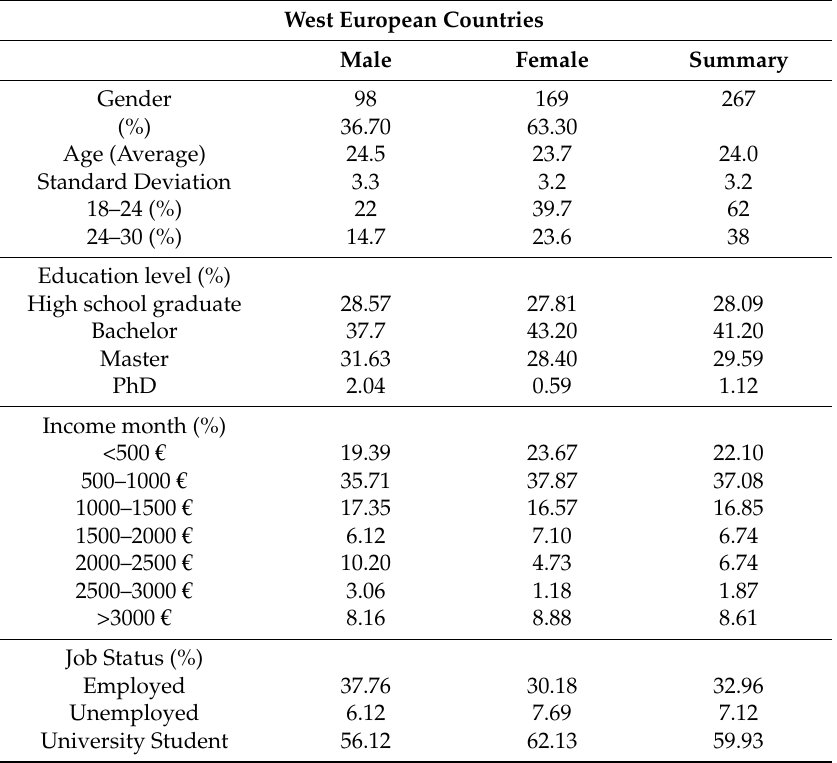
Table 3. Subset 2 sample ( n = 267). West European Countries Male Female